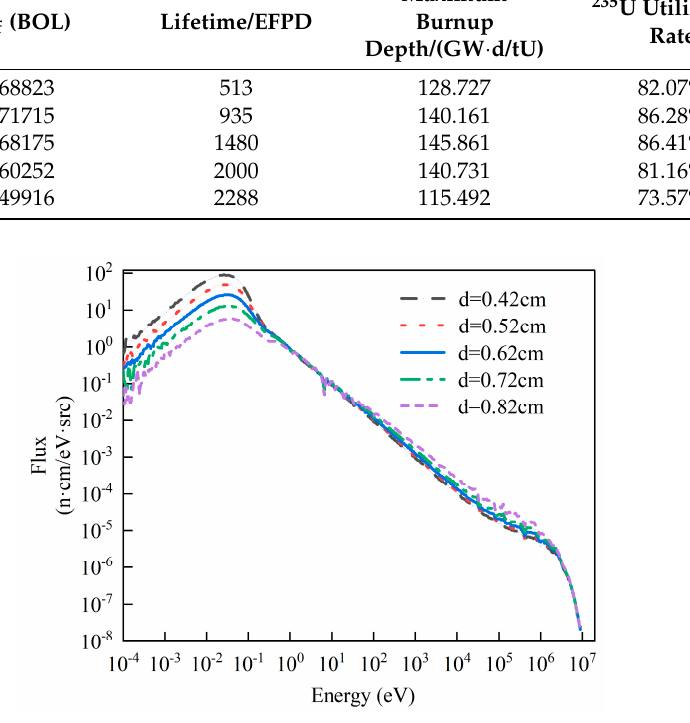
Figure 8. Neutron energy spectra at different rod diameters.